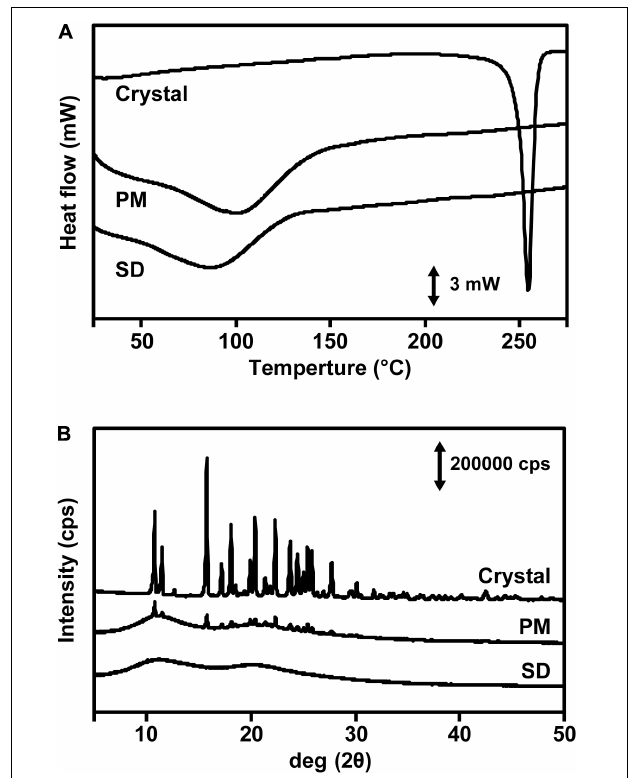
FIGURE 2 | Physicochemical evaluation of NRG SD. (A) DSC thermograms of crystalline NRG, PM, and NRG SD. (B) PXRD analyses of crystalline states of NRG, PM, and NRG